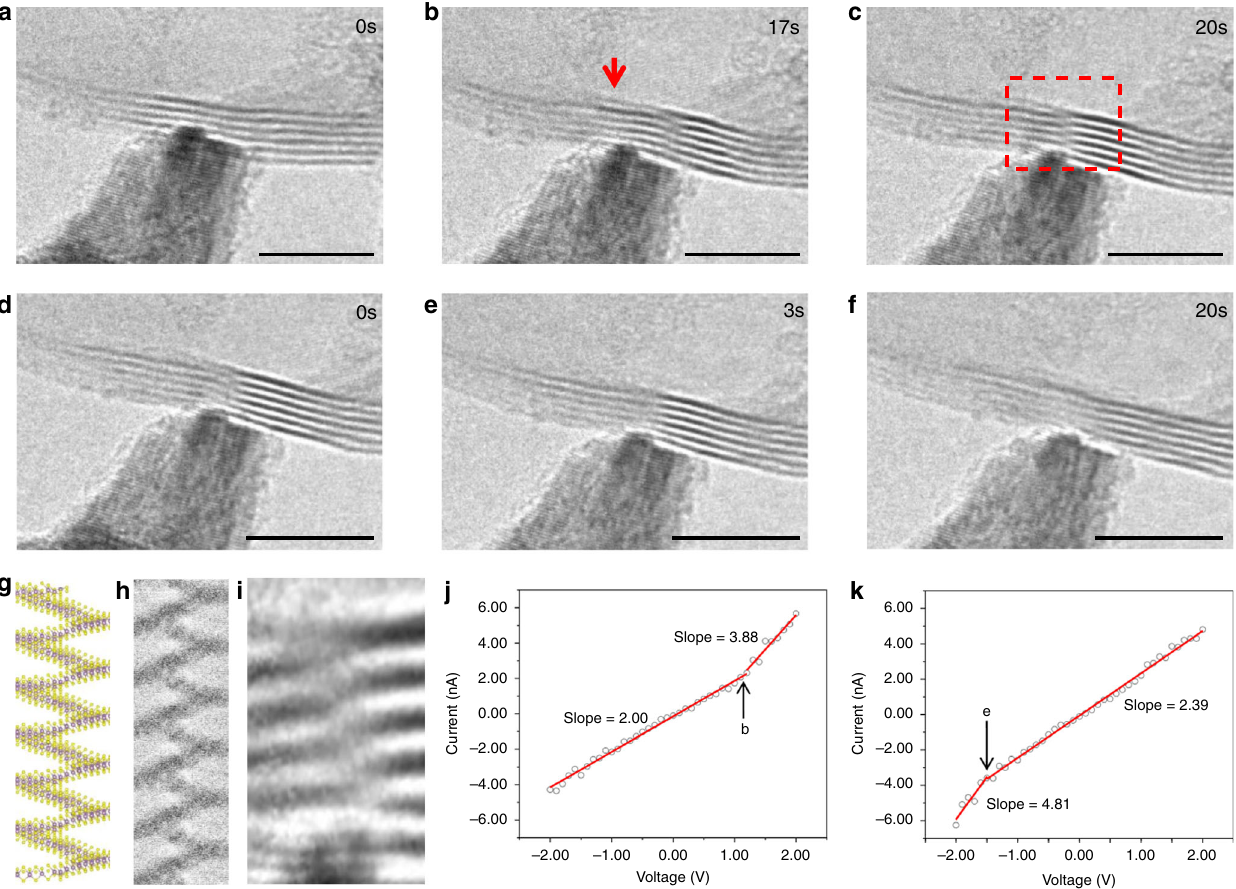
Fig. 5 In situ observation of the formation/elimination of a single screw dislocation in the contact area. TEM images of screw dislocation appearing during measurement at a 0 s, b 17 s, and c 20 s. TEM images of screw dislocation disappearing during measurement at d 0 s, e 3 s, and f 20 s. g Atomic model, h simulated HREM image (by JEMS using multislice method), and i experimental image enlarged from the red dash box on c along zone axis [010]. j Current – voltage curve for the measurement of a – c and k current – voltage curve for the measurement of d – f . The highlighted turning points in j and k correspond to the snapshots of b , e above, respectively. Scale bars in a – f = 5